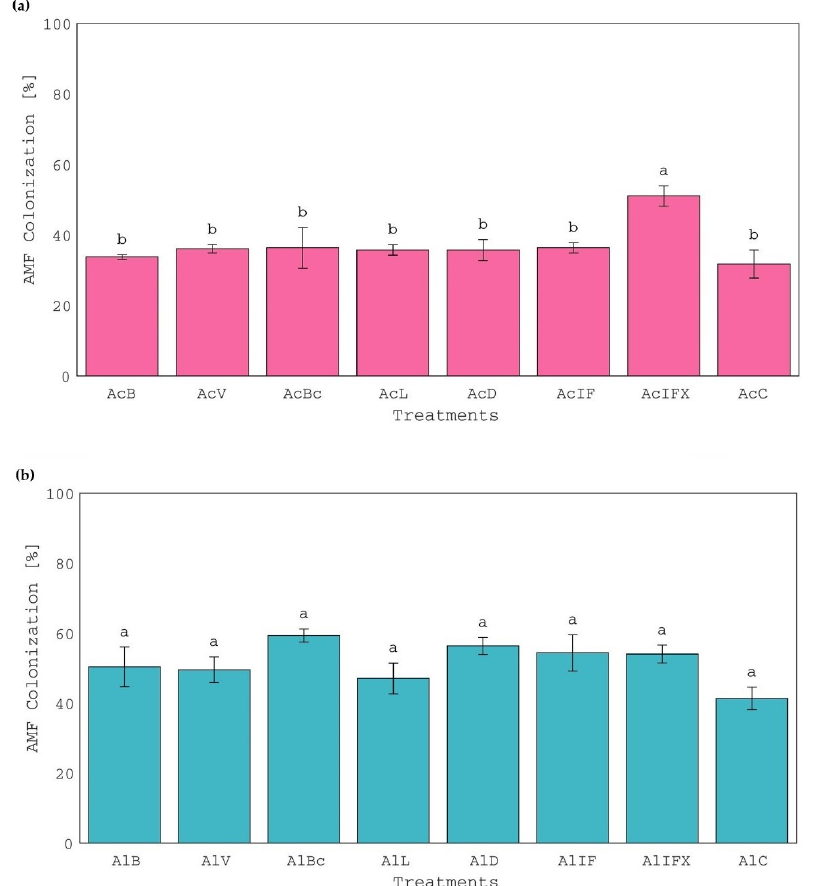
Figure 4. Percentages of AMF root colonization of white clover plants, grown in ( a ) acid soil treatments and ( b ) alkaline soil treatments. Treatment of the acid and alkaline soil, respectively, with: AcB and AlB: bentonite-treated sludge; AcV and AlV: vermiculite-treated sludge; AcBc and AlBc: biochar-treated sludge; AcL and AlL: limed sludge; AcD and AlD: air-dried sludge; AcIF and AlIF: N-P-K inorganic fertilization; AcIFX and AlIFX: P-K inorganic fertilization; AcC and AlC: control. Different letters, within each soil, indicate significant differences among means, using the LSD test, at p ≤ 0.05.